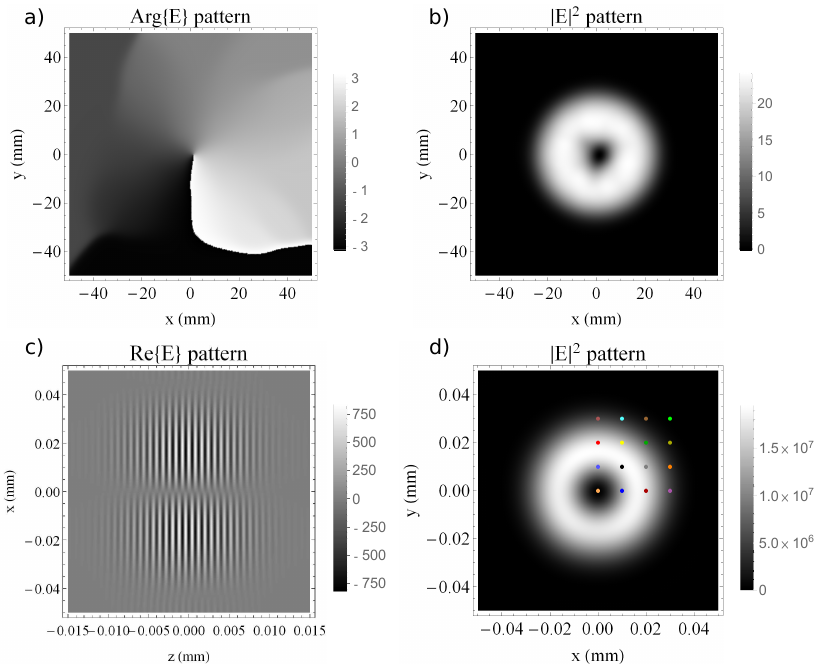
Figure 2. ( a ) The phase profile of the laser field after being reflected by the helical mirror, at z = 0. 2 time-integrated) of the laser field after being reflected by the helical ( b ) The fluence profile ( E | | mirror, at z = 0. ( c ) The field profile ( Re ) on x E z of the laser field after being reflected by the { } − 2 time-integrated) helical mirror and focused with an f = 1500 mm mirror. ( d ) The fluence profile ( E | | of the laser field after being reflected by the helical mirror and focused with an f = 1500 mm mirror. The dots are marking the positions where the temporal profiles are plotted in Figure 3, with the corresponding